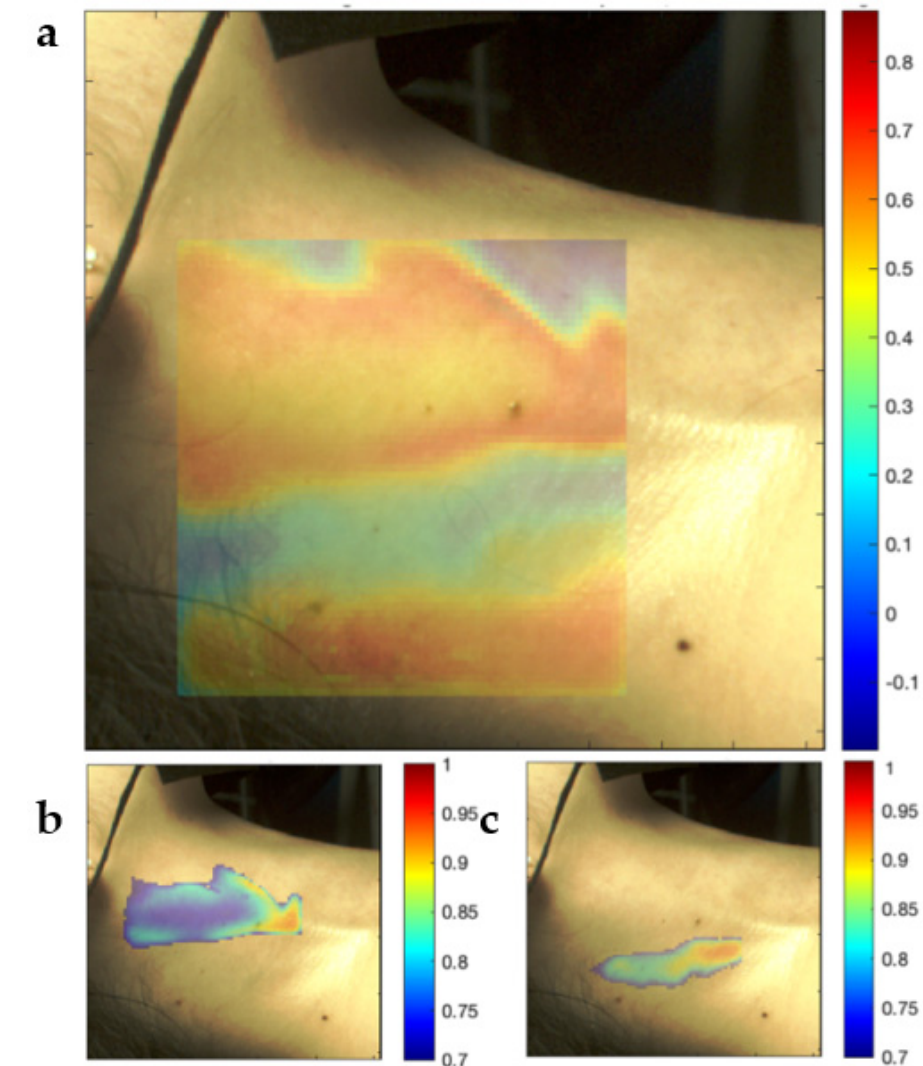
Figure 6. False color maps representing the Pearson correlation of local SRVI signals to the global SRVI signal ( a ) and of local SRVI signals to the average SRVI signal within high-correlation sub-regions segmented using spatial clustering ( b , c ).